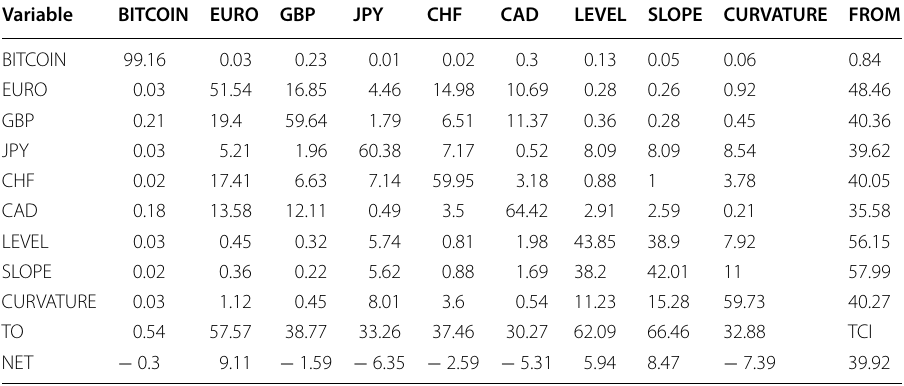
The table presents the static analysis of the full sample of the exchange rates of Bitcoin and safe haven currencies (EURO, GBP Great British Pound, JPY Japanese Yen, CHF Swiss Franc, CAD Canadian Dollar) and the components of the = = = = US yield curve (Level, Slope and Curvature). ‘From’ (last column) mean spillover of the system of all other variables to the variable. ‘TO’ (second to last row) shows spillover from each variable to the system of all other variables. Net (last row) shows the net directional spillover of each variable. TCI (bold right bottom corner) is the total connectedness index of the system of all